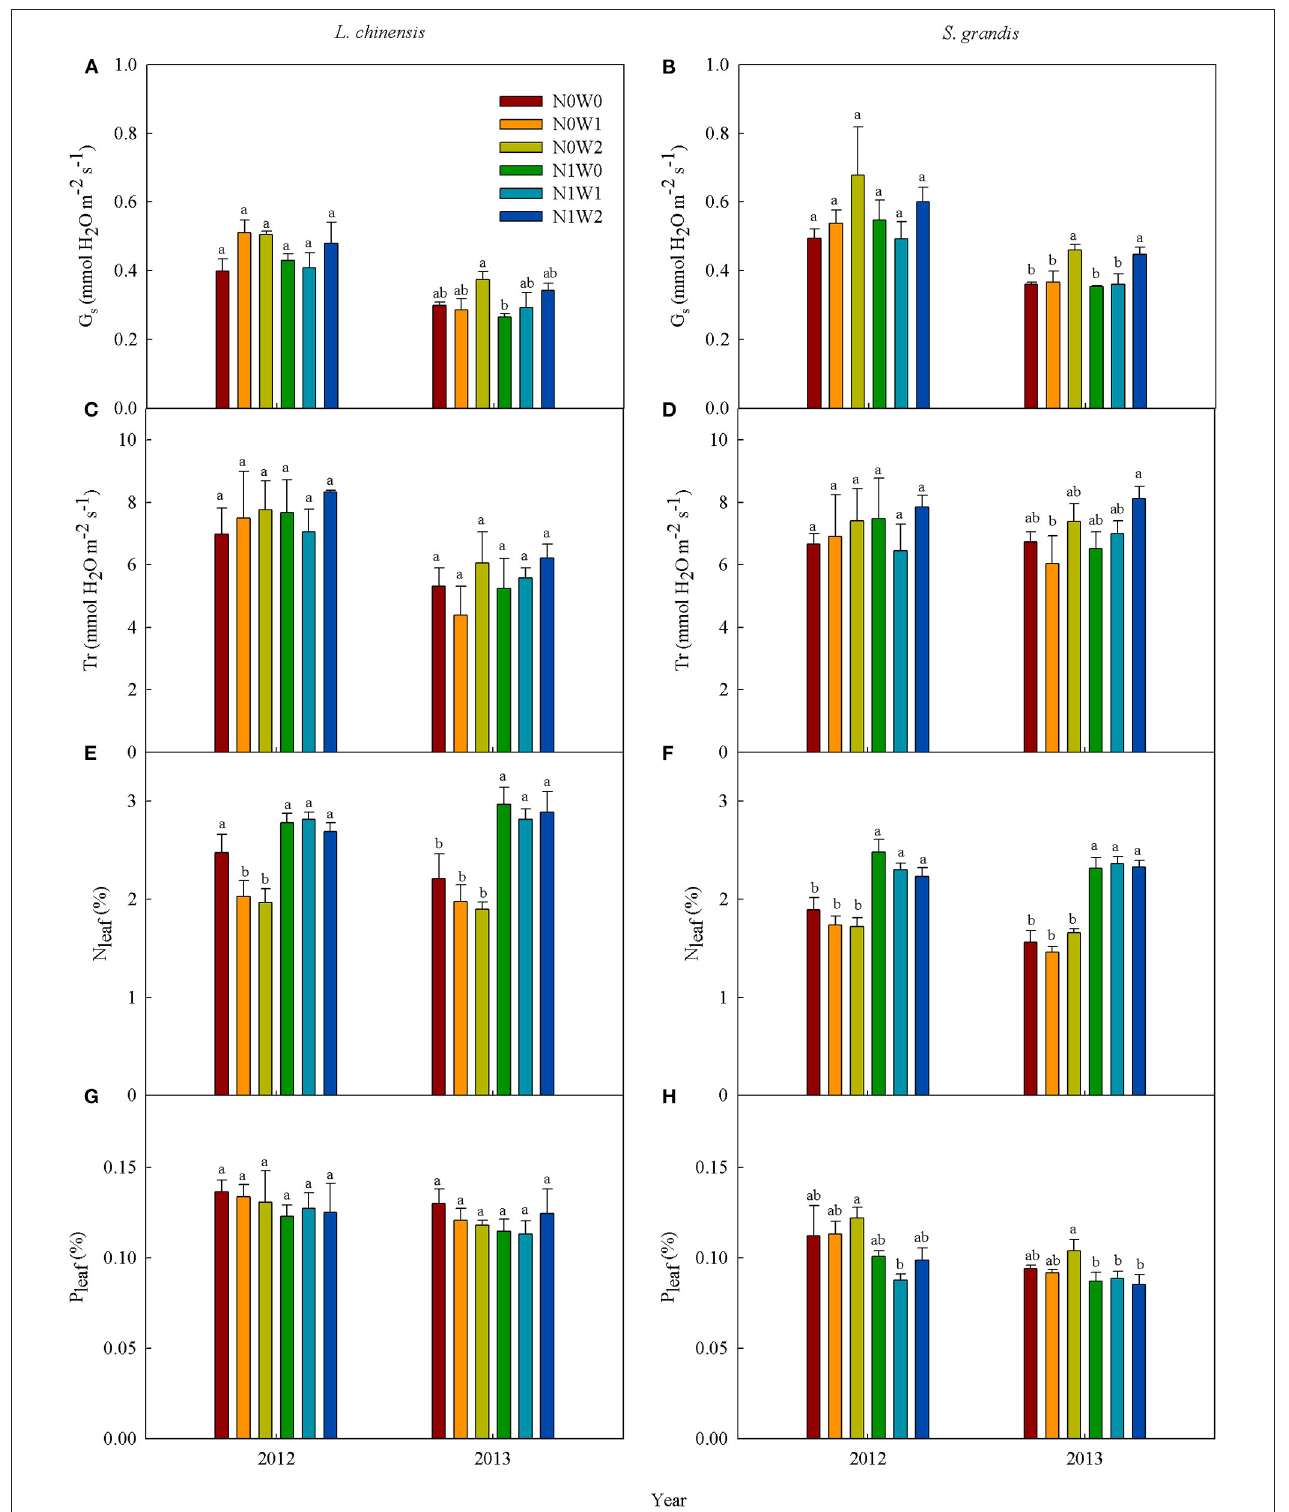
FIGURE 5 | Mean values of leaf photosynthetic characteristics of Leymus chinensis (left panels) and Stipa grandis (right panels) across seasons in 2012 and 2013, respectively. (A,B) Stomatal conductance (G s ), (C,D) transpiration rate (Tr), (E,F) leaf N concentration (N leaf ), and (G,H) leaf P concentration (P leaf ). Different letters indicate significant differences ( P < 0.05) among six treatments. Values represent mean ± SE ( n = 3).